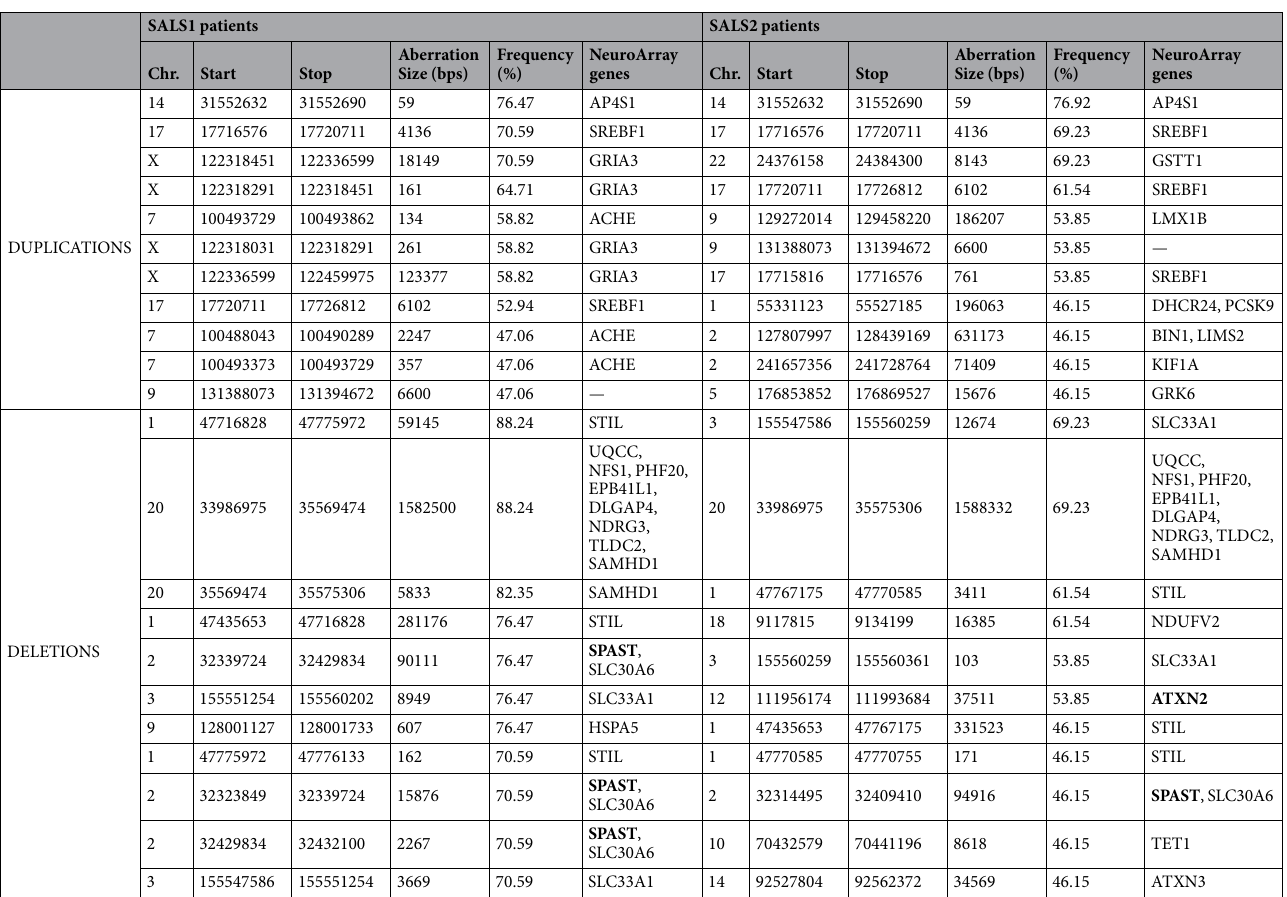
Table 1. The top most frequent copy number gain and loss in both SALS patient subgroups. The table lists the gains and losses that occurred in at least 10% of the two previously characterized transcriptome-based SALS subgroups. The chromosomal regions, including the start and end positions, aberration size, frequency in SALS patients and CNV embedded NeuroArray genes are listed. Chromosomal positions are referred to the human reference sequence hg19 assembly. Genes previously identified as potential risk factors in ALS are in